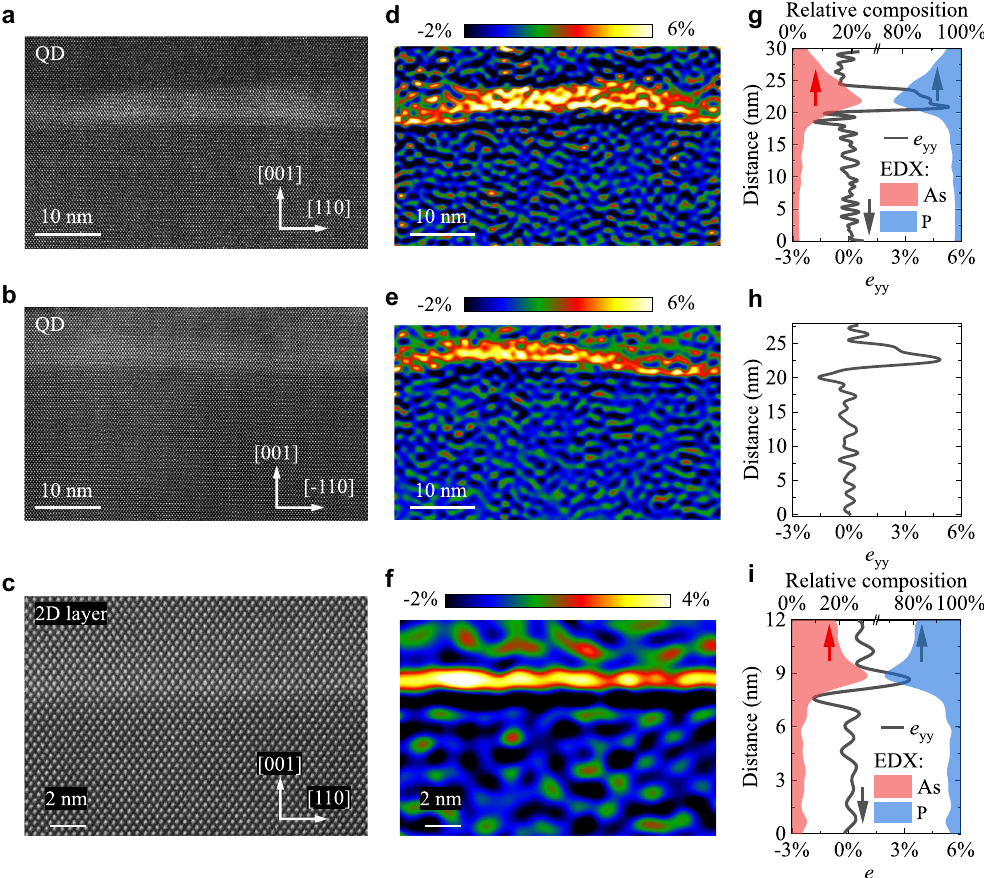
Figure 2: Morphological investigation of the buried annealed DE QDs by STEM and EDX. QDs in cross-section geometry viewed along the (a) [110] and (b) [110] directions, and (c) the 2D InAs(P) layer. (d)–(f) Maps representing the fractional change in lattice spacing along the [001] , for each of the images in (a)–(c). (g)–(i) Line scan profiles of P (blue) and As (red) concentrations direction (relative to the InP lattice), e yy (black lines) along the [001] measured by EDX, and the lattice displacement values e yy